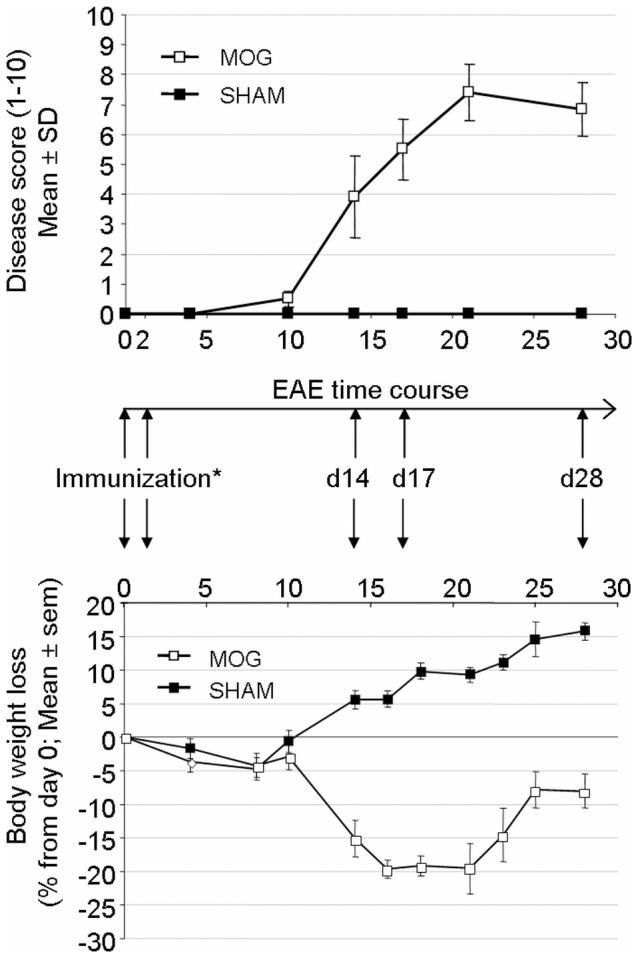
Disease course of mice undergoing EAE after immunization with rat MOG35-55.*Mice were immunized s.c. with rat MOG 35−55. Pertussis toxin was administered i.p. at day 0 and day 2. 12 animals per group were included in this study. Neurological impairment was monitored using a ten-point standardized rating scale and expressed as Mean ± Standard Deviation. Spinal cord and cerebellum were taken at day14 (D14), day17 (D17) and day28 (D28) in MOG-induced (n = 4) and SHAM mice (n = 4). The body weight was monitored over the disease time course and the body weight loss ± SEM was reported. Disease onset occurred at day 10 and reached a maximum at day 22.